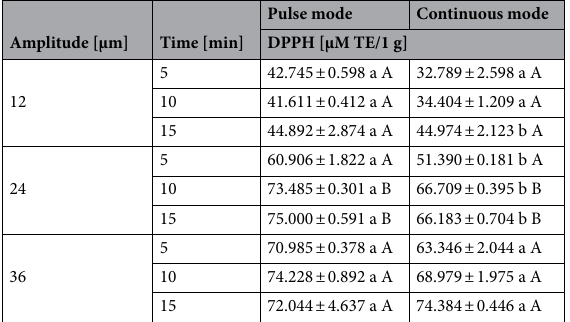
Table 1. DPPH values in individual extracts. a, b—different letters show statistically significant differences in Tukey’s test in row (< 0.05). A, B—different letters show statistically significant differences in Tukey’s test in column for one amplitude (< 0.05).